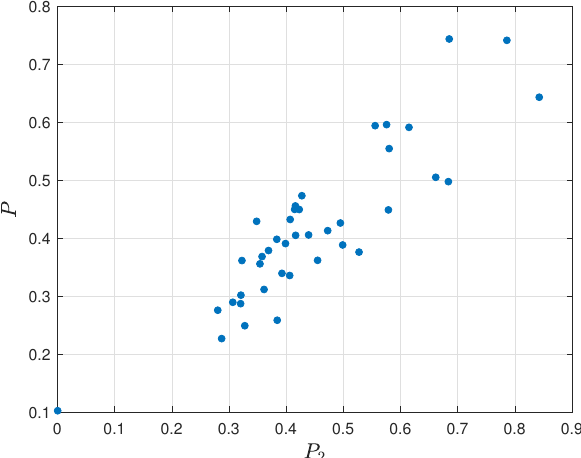
Figure 24. The relation diagram of the Frag gaining assessment ( P 2 ) for final assessment P